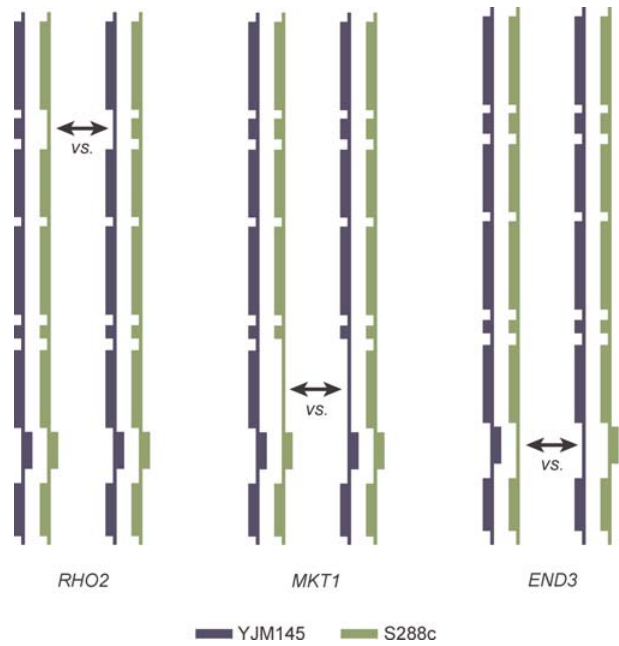
Figure 1. Reciprocal Hemizygosity Analysis The vertical lines represent the chromosome XIV QTL, and the boxes on the line represent individual genes in the Htg QTL. In RHA, for each Htg QTG (RHO2, MKT1, and END3), one allele of each QTG (or putative QTG) is deleted in a hybrid strain resulting in a pair of deletion